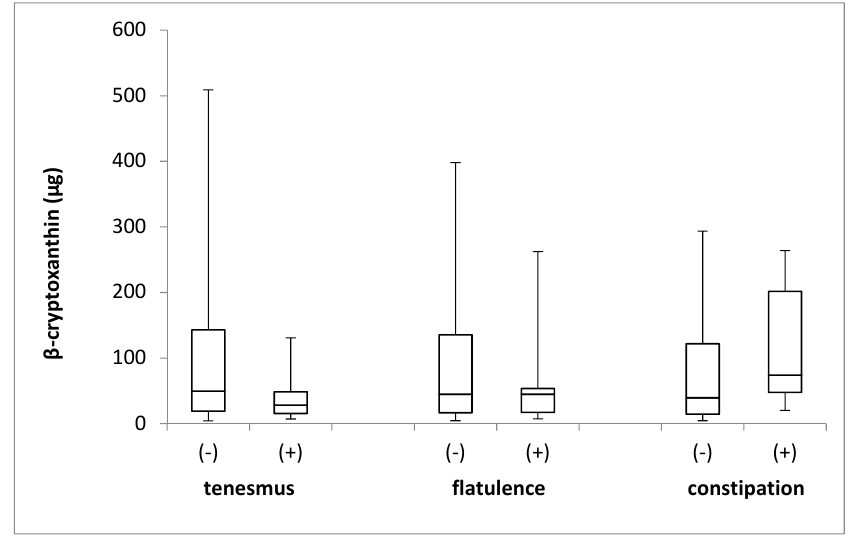
Figure 4. The box plots of α -carotene intake in groups of individuals stratified by the analyzed symptoms of tenesmus, flatulence and constipation. (-) symptom not declared; (+) symptom declared. The β -cryptoxanthin intake in the groups of individuals stratified by the incidence of tenesmus, flatulence, and constipation is presented in Figure 5. No differences in the levels of β -cryptoxanthin intake were identified between the groups, with respect to the incidence of tenesmus ( p = 0.227; Mann–Whitney U test), flatulence ( p = 0.806; Mann–Whitney U test), and constipation ( p = 0.181; Mann–Whitney U test).